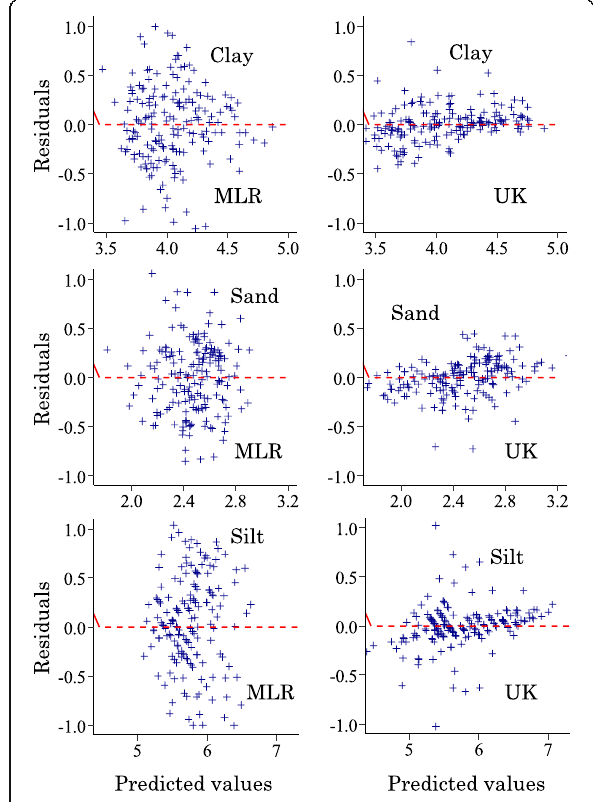
Fig. 6 Homoscedasticity and improvement of residuals from multiple linear regression (MLR) with backward selection method to universal kriging (UK) with exponential variogram applied to Clay, Sand, and Silt texture